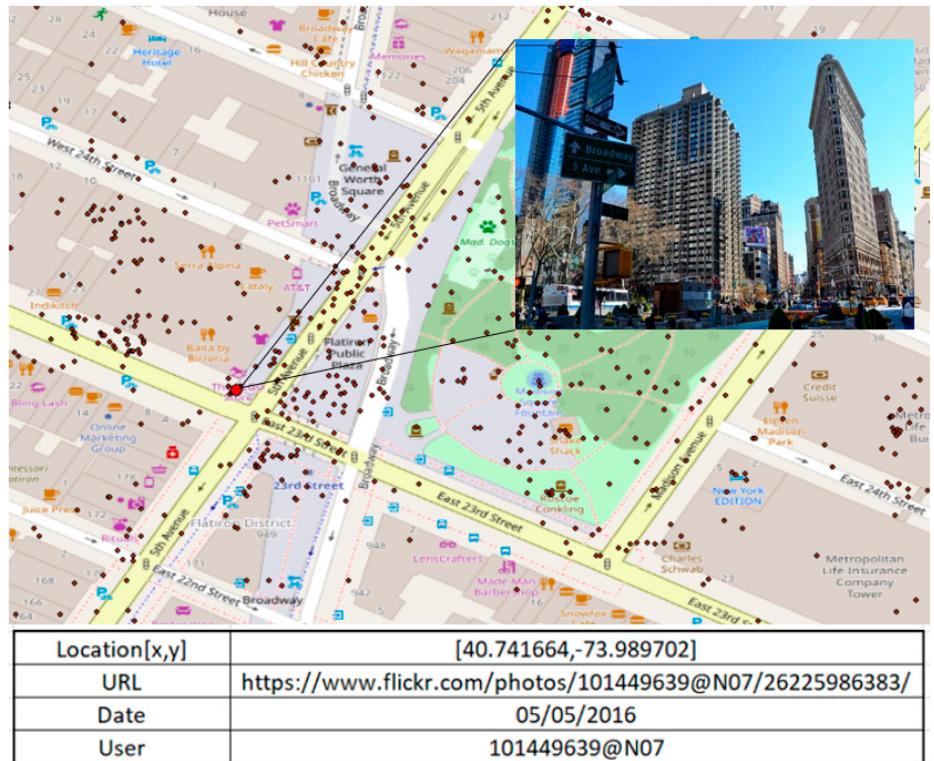
Figure 1. Broadway on 23rd street, Manhattan, NYC, with superimposed Flickr photo locations (depicted as points, background), and metadata of a specific photo (bottom). Background: Google Maps.